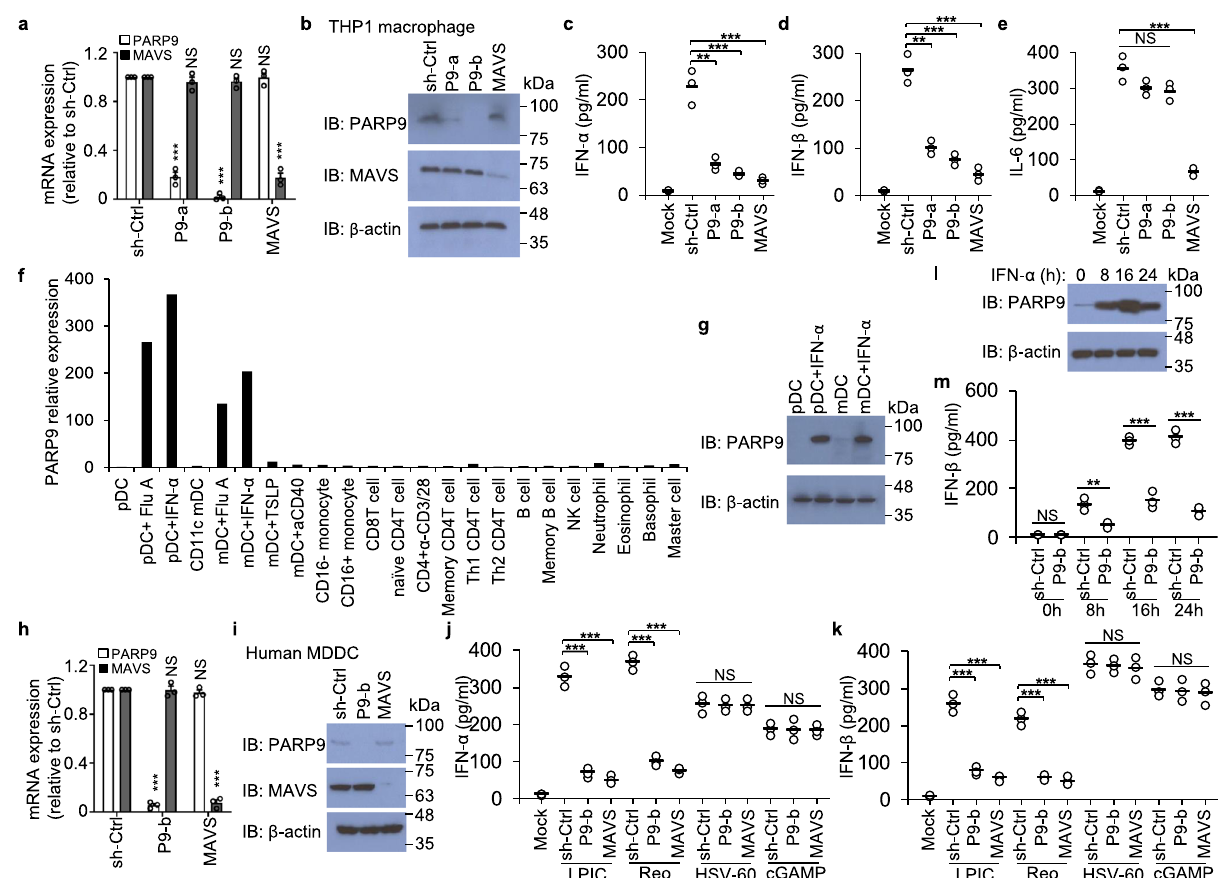
Fig. 1 PARP9 promotes type I IFN production in human innate immune cells in response to poly I:C stimulation or RNA viral infection. The RT-qPCR ( a ) and immunoblot (IB, b ) analysis of PARP9 or MAVS at mRNA ( a , n = 3 per group) and protein ( b ) levels in THP-1 macrophages treated with shRNA to knockdown expression of PARP9 (sequence P9-a and P9-b) or MAVS. A scrambled shRNA served as a control (sh-Ctrl). The β -actin served as the loading control. ELISA of IFN- α ( c ) IFN- β ( d ), and IL-6 ( e ) production from THP-1 macrophages treated with the indicated shRNA after a 10h stimulation with 0.5 μ g/ml of long poly I:C delivered by Lipofectamine 3000 ( n = 3 per group). f Human myeloid cells and lymphoid cells were puri fi ed from PBMCs using a cell sorter. Total RNA was isolated from these primary cells induced or not to chip hybridization and microarray. The pro fi le of PARP9 expression in different cells is indicated. The relative expression of PARP9 was compared by plotting the values extracted from the gene expression database. A value <1 indicated the absence of gene expression. g Immunoblot (IB) analysis of PARP9 and β -actin in plasmacytoid dendritic cells (pDCs), myeloid dendritic cells (mDCs), and pDCs and mDCs induced with IFN- α (100 U/ml) for 2h. The RT-qPCR ( h , n = 3 per group) and immunoblot ( i ) analysis of PARP9 or MAVS at mRNA ( h ) and protein ( i ) levels in human monocyte-derived dendritic cells (MDDC) treated with shRNA to knockdown expression of PARP9 (sequence P9-b) or MAVS. A scrambled shRNA served as a control (sh-Ctrl). ELISA of IFN- α ( j ) and IFN- β ( k ) production from human MDDC treated with the indicated shRNA after a 10h stimulation with 0.5 μ g/ml of long poly I:C (LPIC), dsDNA from HSV-1 virus (HSV-60, 2.5 μ g/ml) or cGAMP (1.0 μ g/ml) delivered by Lipofectamine 3000 or 12h infection with Reovirus (Reo) at an MOI of 5 ( n = 3 per group). l Immunoblot analysis of PARP9 expression dynamics in human MDDC treated with IFN- α (500 U/ml) for 0h, 8h, 16h and 24h. m ELISA of IFN- β production dynamics in human MDDC treated with the indicated shRNA after stimulation with 0.5 μ g/ml of LPIC for indicated time (n = 3 per group). Each circle represents an individual independent experiment and small solid black lines indicate the average of triplicates for results in c – e , j , k and m . Mock, scrambled shRNA-treated cells without stimulation. Error bars indicate standard error of the mean for results in a , h . NS, not signi fi cant ( p >0.05), * p <0.05, ** p <0.01, *** p <0.001, and p value was calculated by unpaired two-tailed Student ’ s t test. Data are from one experiment with duplicate ( f ) or representative of three independent experiments ( a – e , j – m ). Exact p values ( a , p = 0.000026, p = 0.378, p <0.000001, p = 0.276, p = 0.929, p = 0.000028; c p = 0.0019, p = 0.00099, p = 0.00077; d p = 0.0011, p = 0.00057, p = 0.00035; e , p = 0.063, p = 0.00018; h p <0.000001, p = 0.924, p = 0.346, p <0.000001; j p = 0.00014, p = 0.000095, p = 0.000053, p = 0.000024, p = 0.826, p = 0.73; k p = 0.00025, p = 0.00013, p = 0.00018, p